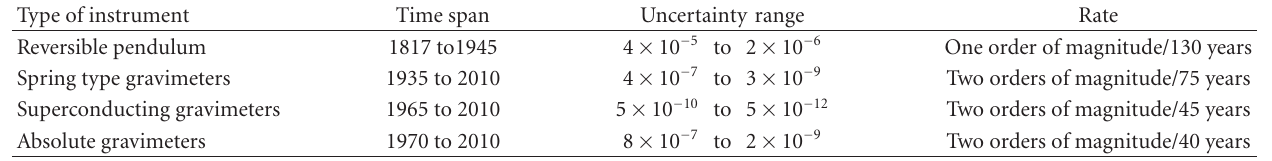
Table 2: Progress in measuring g (partially compiled after Torge 1989, page 14, figure 1.1